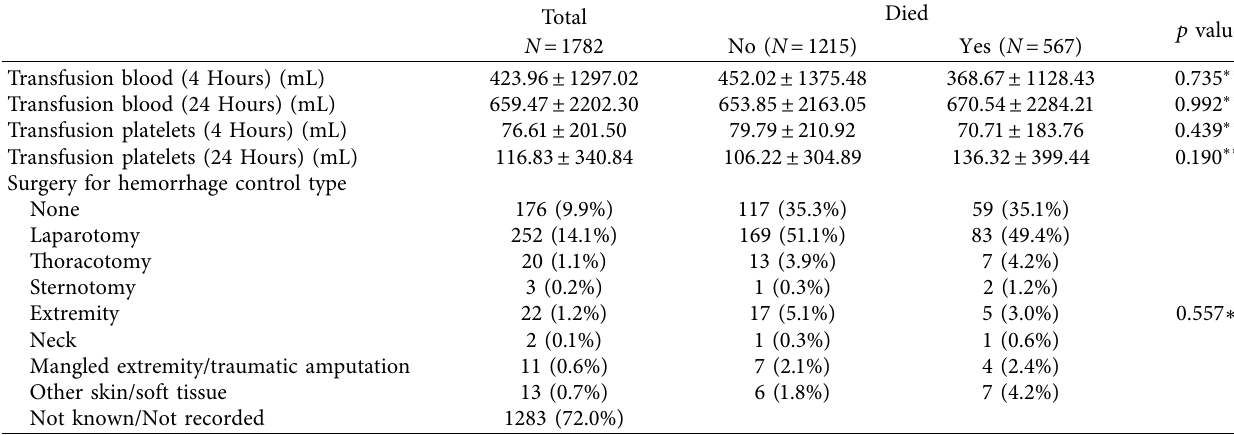
Table 3: Table showing the therapeutic interventions undergone by the trauma patients who developed sepsis during this hospital stay.